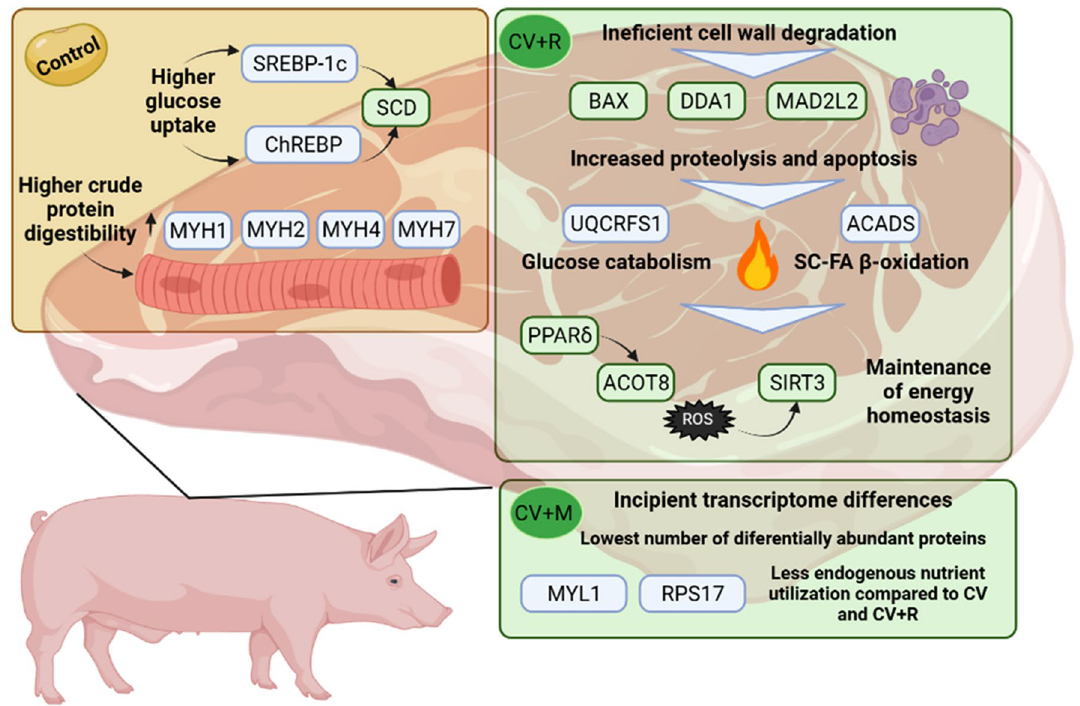
Figure 6. A summary of the main results obtained in the transcriptome and proteome of the longissimus lumborum muscle of finishing pigs. Figure created using